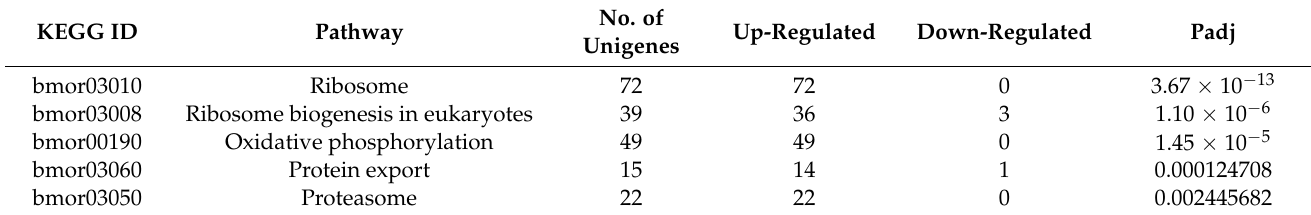
Table 4. KEGG function classification of differentially expressed